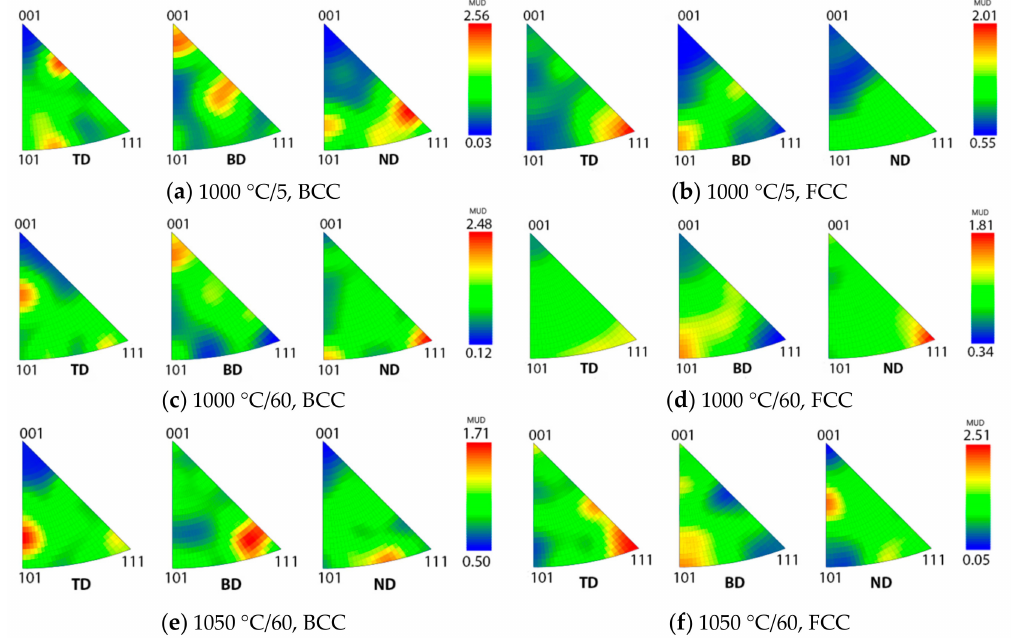
Figure 9. Pole figures of BCC (ferrite) and face-centered cubic (FCC; austenite) phases of heat-treated specimens: ( a , b ) 1000 ◦ C / 5 min, ( c , d ) 1000 ◦ C / 60 min, and ( e , f ) 1050 ◦ C / 60